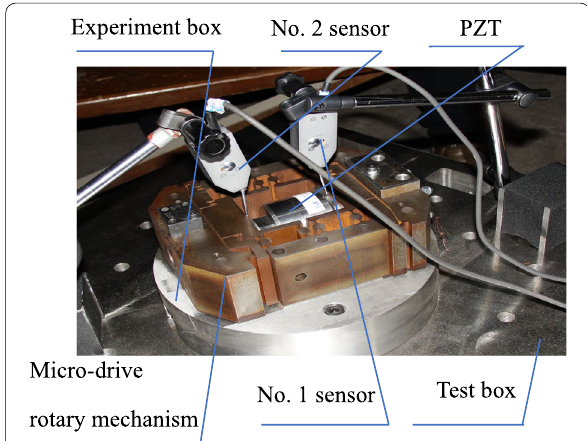
Fig. 4 Driving performance experiment diagram of PZT ceramic